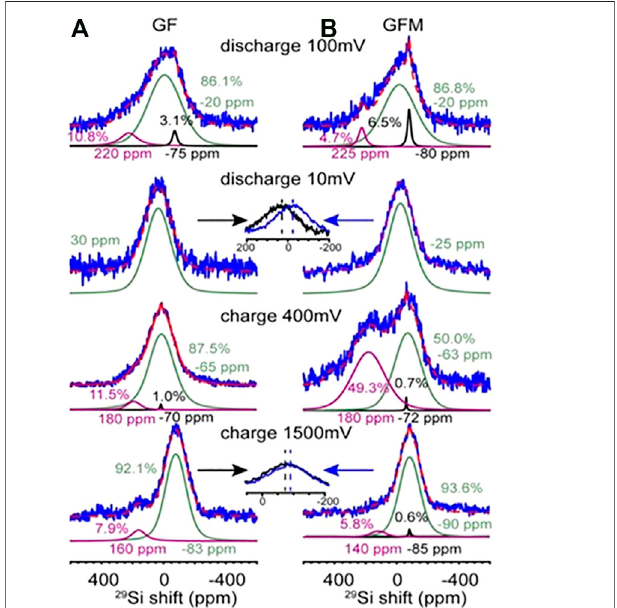
FIGURE3| 29 SiNMRspectra(solidline)and simulation/ fi tting(dashline) of GF (A) and GFM (B) at 100, 10, 400, and 1,500 mV. Peaks around − 80 ppm are from unreacted crystalline Si, the broad resonance(s) at − 15 ppmisfromLixSi,whereasthepeakaround220 ppmisascribedto small Si clusters. When discharging to 100 mV, the majority of reacted Si is either in isolated Si or small Si clusters. For the fully lithiated samples, both GF (30 ppm) and GFM ( − 25 ppm) show one single broad peak with different chemical shifts. The shift difference is due to the presence of Li − Mg − Si phases. Upon charge to 400 mV, a signi fi cant amount (~49.3%) of LixSi is observed in GFM cells, compared with only 11.5% residual Siin the GF cell. In the fully delithiated state, Si shifts of both GF ( − 83 ppm) and GFM ( − 90 ppm) cells shift toward lower frequencies. (Reproduced from Reference